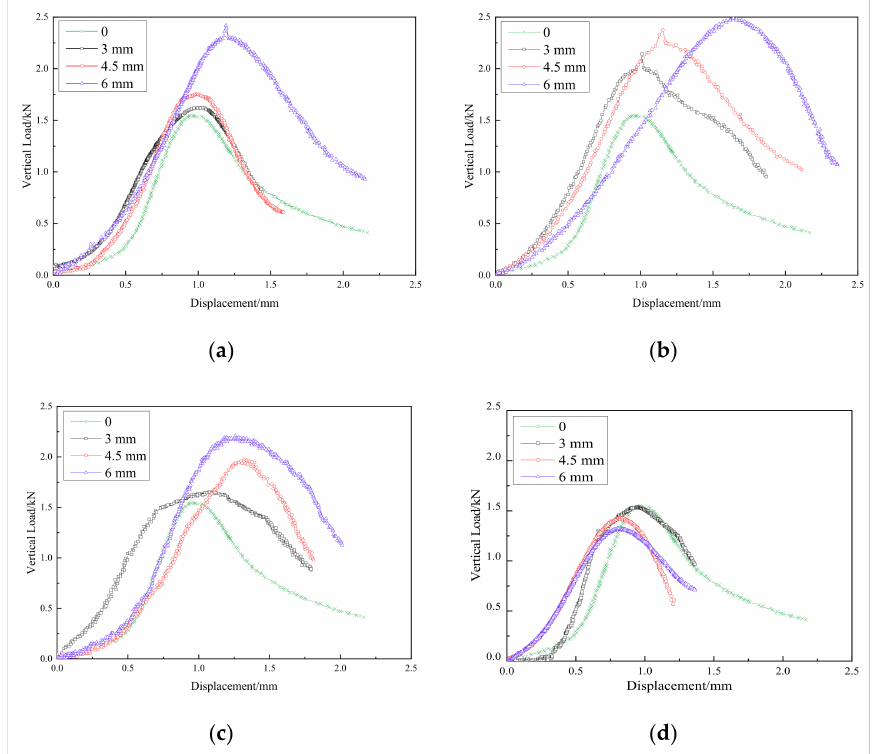
Figure 6. Vertical load–displacement curves of specimens. ( a ) Fiber content 2‰; ( b ) Fiber content 3‰; ( c ) Fiber content 4‰; ( d ) Fiber content